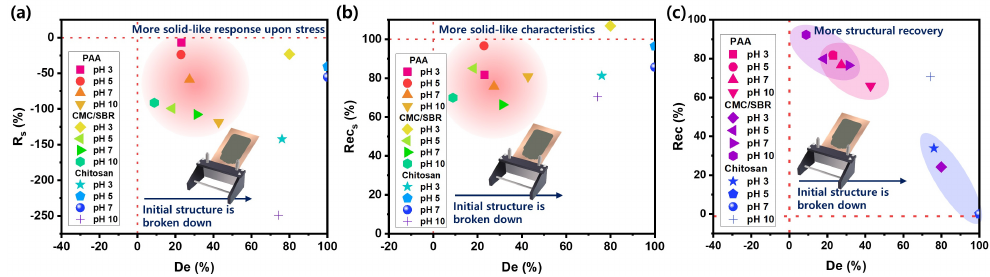
Figure 5. Phase diagrams of ( a ) De — R s , ( b ) De — Rec s , and ( c ) De — Rec for various binders with Si-based anode